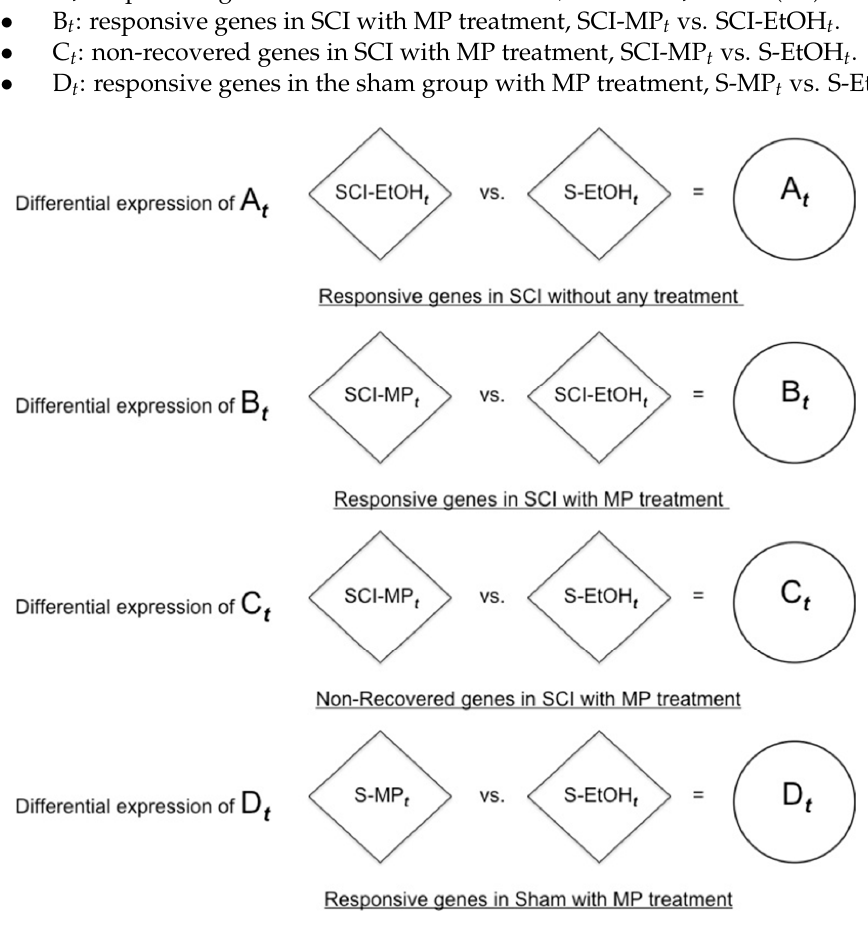
Figure 1. Four differentially expressed gene sets.